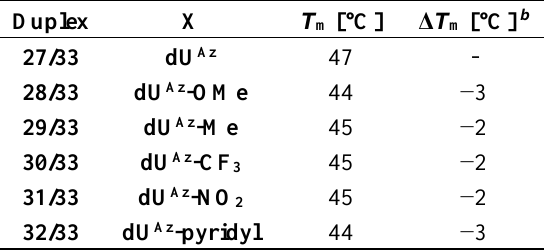
Table 5. T m values of duplexes formed by dU Az analogue-modified ONs with complementary DNA a .